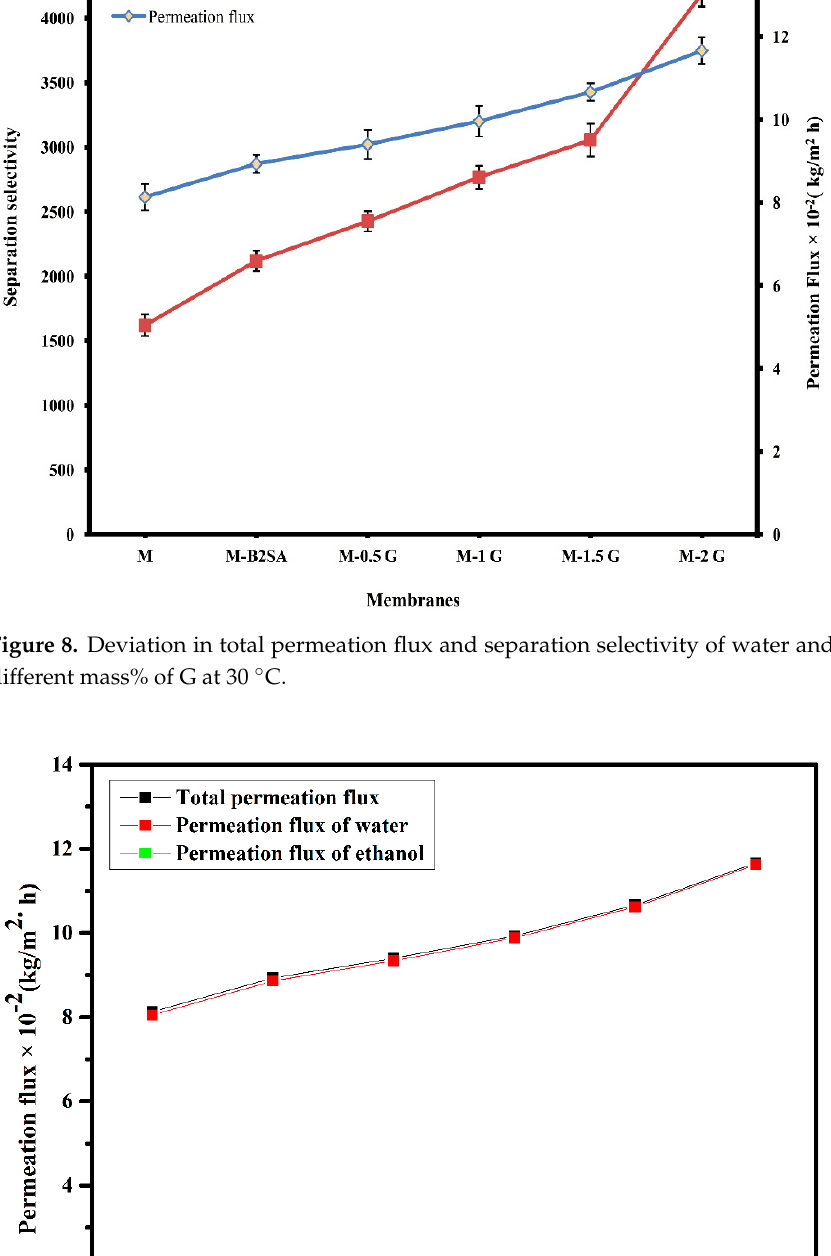
Figure 9. Deviation in total permeation flux and permeation fluxes of water and ethanol at 30 °C.